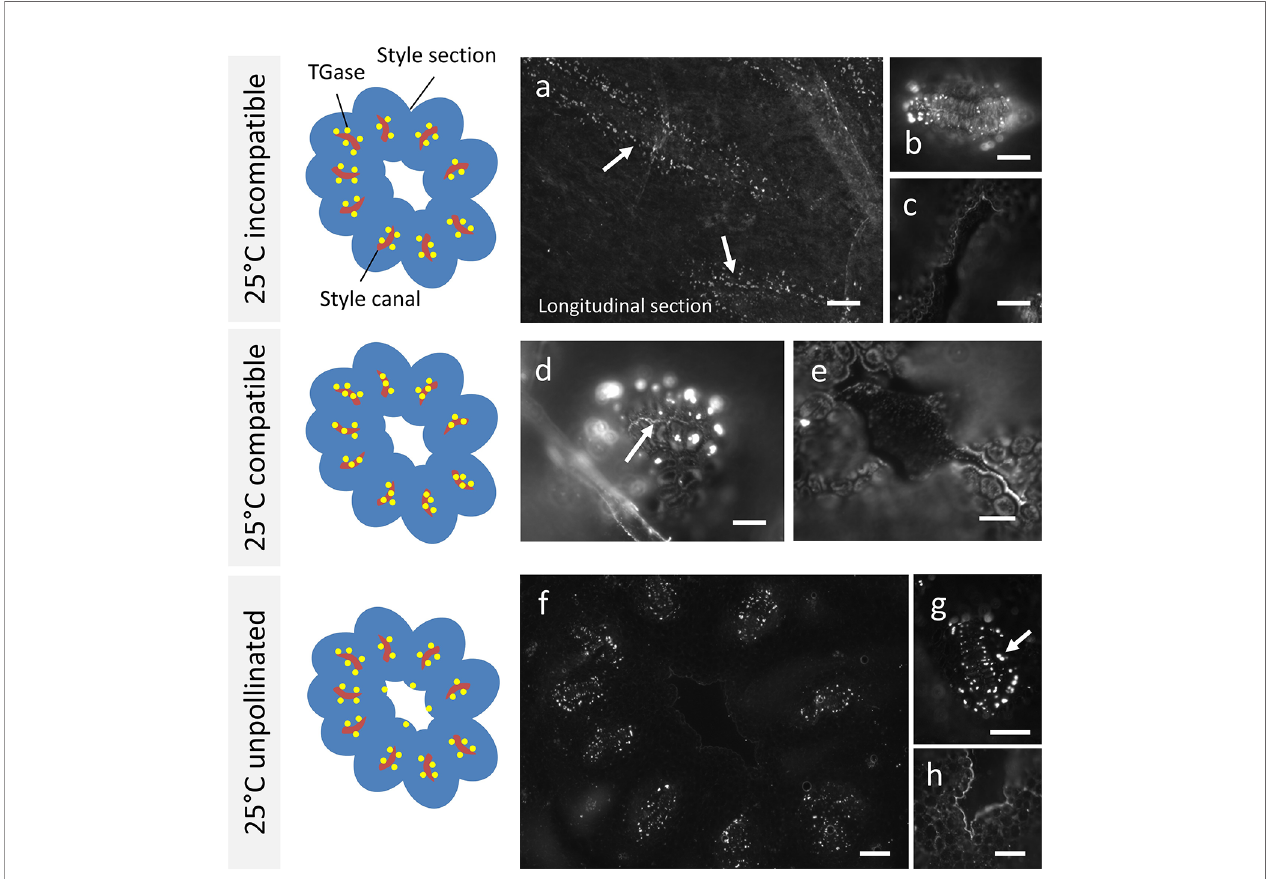
FIGURE 3 | Immunolocalization of TGase during pollen germination in planta at 25°C. Labeling with anti-TGase by fl uorescence microscopy in pollinated, unpollinated, compatible, and incompatible pistils at 25°C 10 days after pollination of fl owers. For each presented case, the drawing on the left shows schematically the cross section of style (in blue) with the stylar canals (highlighted in red) and the distribution of TGase (yellow spots). (A) In the incompatible cross, TGase is found outside the style canal, as shown by the longitudinal section. (B) Detail of a cross-section of a style canal, with clear localization of TGase around the style canal. (C) The style canal does not show the TGase signal. (D) In the compatible cross, an accumulation of TGase can be seen inside the style canal (arrow) as well as outside it. (E) The central duct is not labeled. (F) When the pistil is unpollinated, the TGase signal is distributed outside the style canal, but not inside it. (G) Detail of a single style canal. (H) In a few cases, a weak TGase signal could be observed in the central duct. Scale bars: 100 m